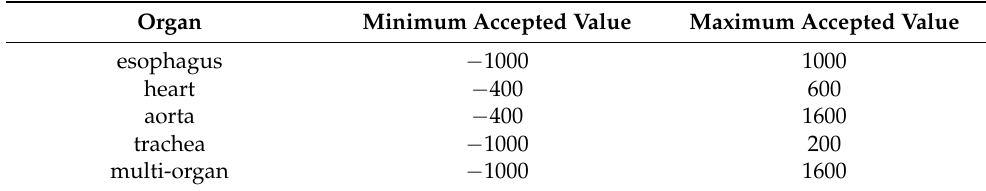
Table 1. Hounsfield scale for the organs of interest.